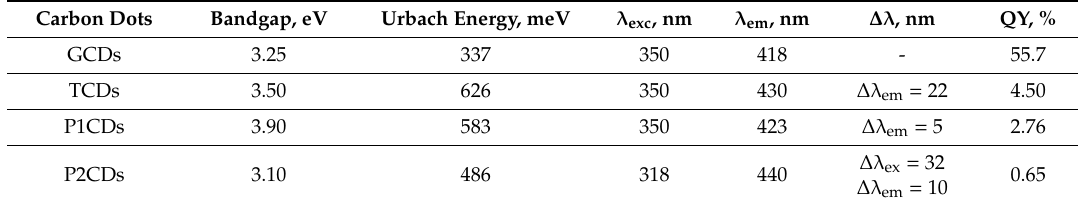
Table 2. Optical and electronic properties of the